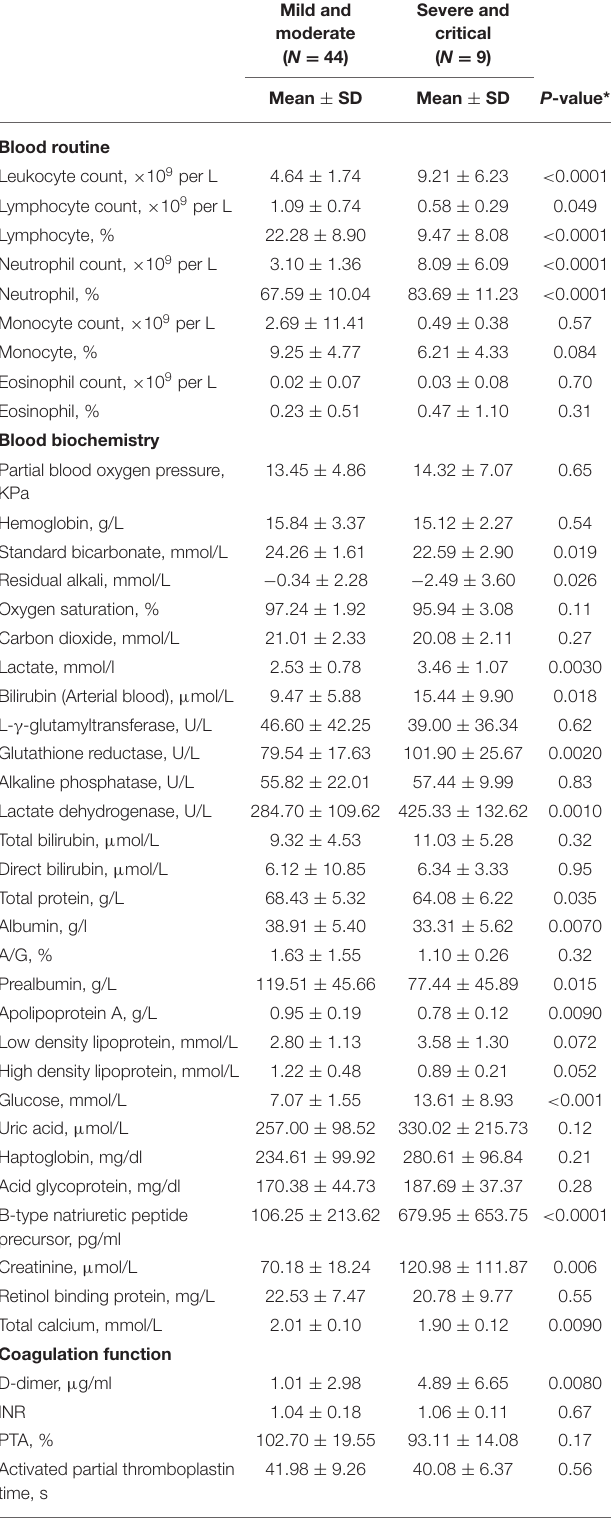
TABLE 2 | Comparison of laboratory examination between patients with mild & moderate or severe & critical types disease. Mild and